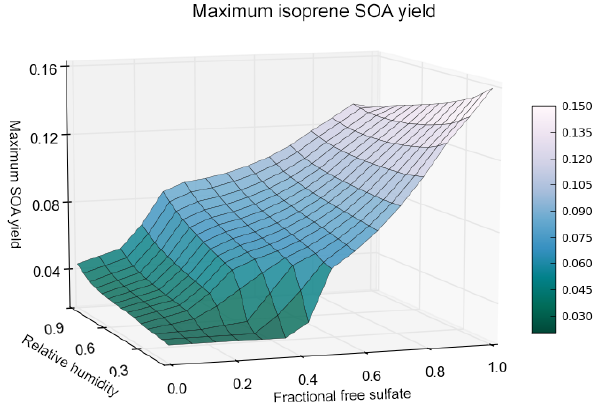
Figure 6. Simulated isoprene SOA yields ( Y SOA = (cid:49) OM /(cid:49) Iso) as a function of relative humidity (RH) and fractional free sulfate − 0 . 5 C )/C ). Using the experimental con- (FFS = ( C NH + 4 SO 2 − 4 SO 2 − 4 ditions of SA1, the RH and FFS were varied to determine the impact of acidity and aerosol liquid water content on Y SOA